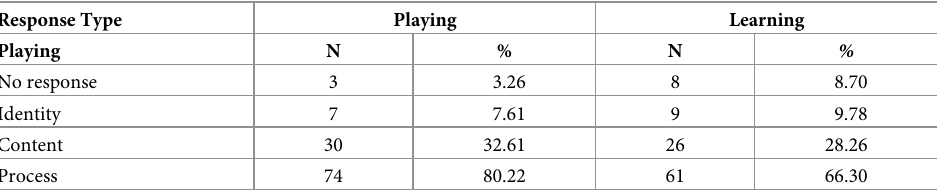
Table 1. Distribution of children’s definitions of playing and